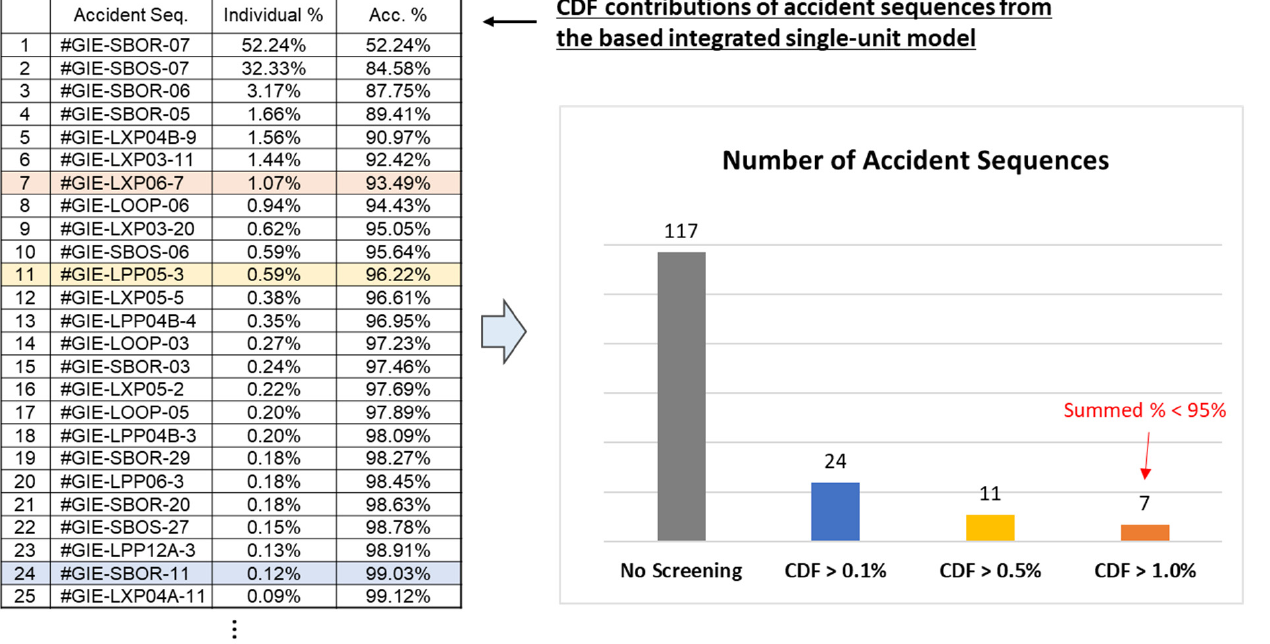
Figure 8. Change in the number of accident sequences in the single-unit model by screening crite- ria.